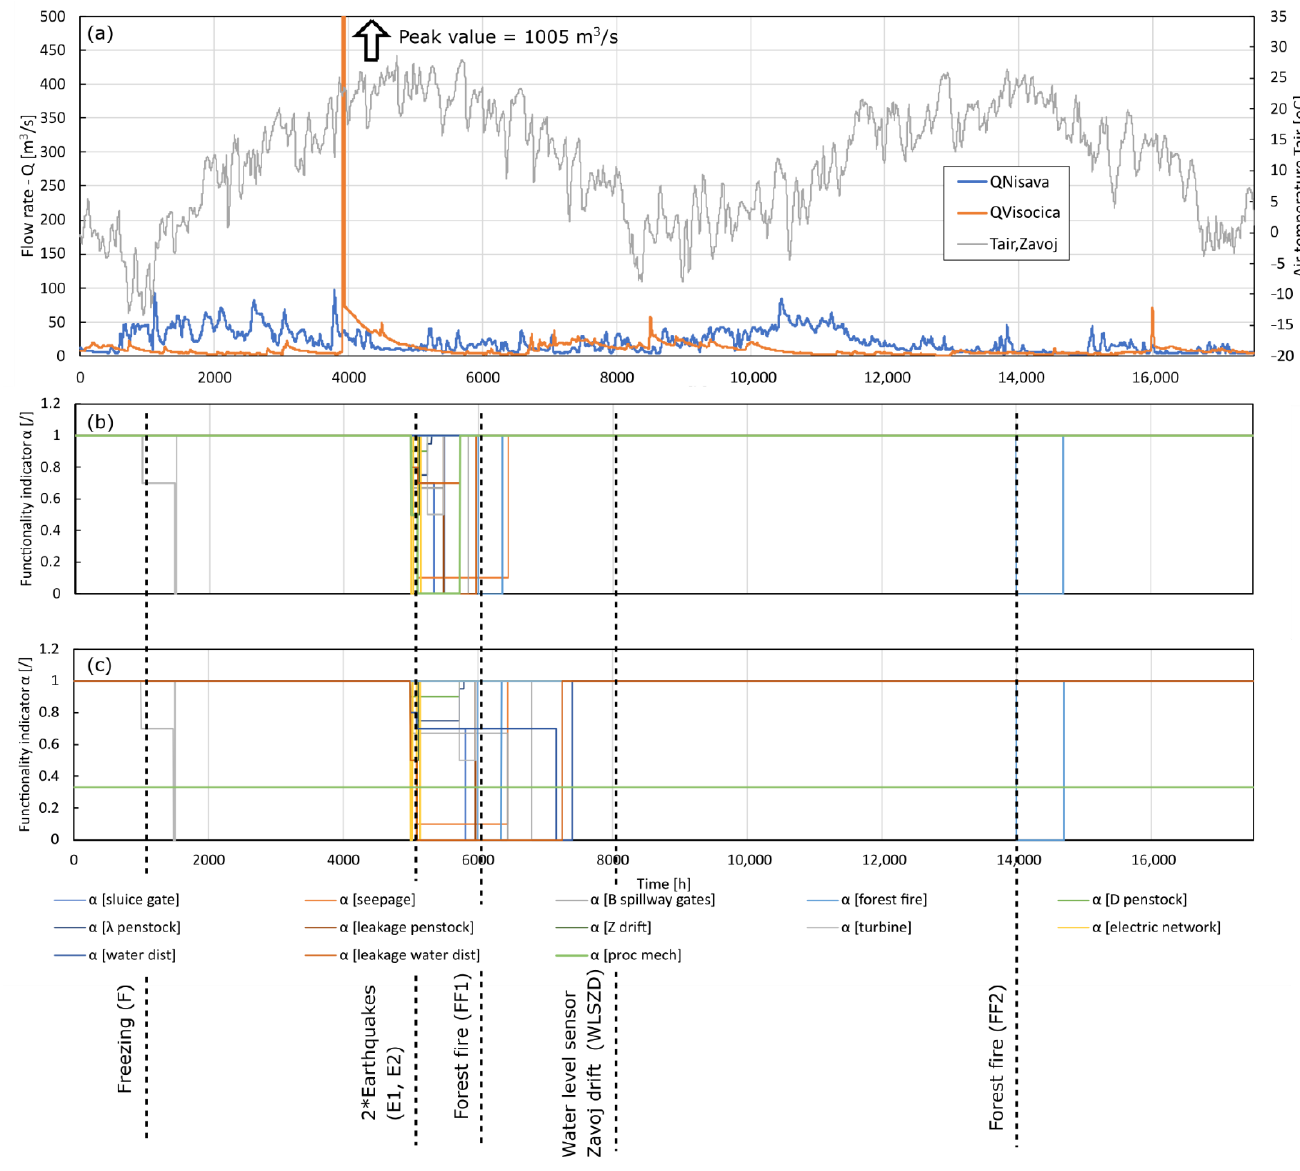
Figure 7. Input time-series: ( a ) Visočica and Nišava River inflows with Zavoj air temperatures; ( b ) functionality indicator time-series for AS1; ( c ) functionality indicator time-series for AS2.